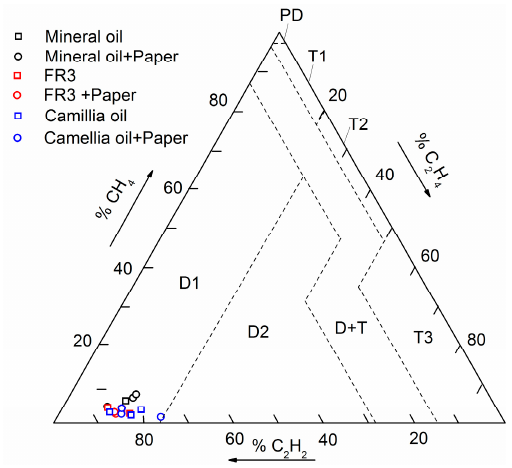
Figure 17. Diagnostic results of simulated electrical faults using Duval Triangle 1.